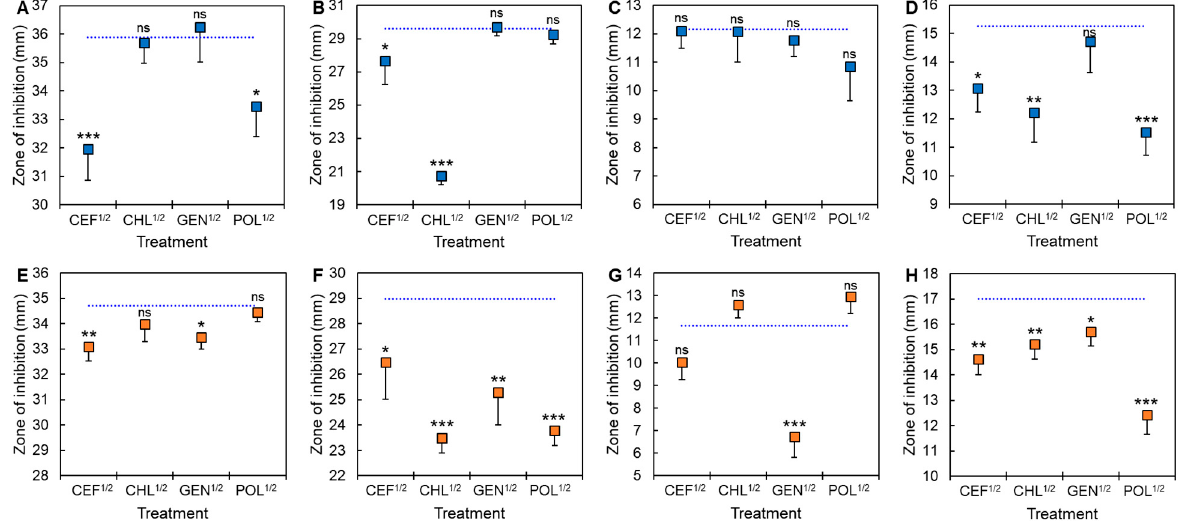
Figure 3. Cross-resistance of Salmonella Typhimurium ATCC 19585 (ST ATCC ; A – D ) and S . Typhimurium CCARM 8009 (ST CCARM : E – H ) exposed to a half minimum inhibitory concentration (MIC) of cefotaxime (CEF 1/2 ), chloramphenicol (CHL 1/2 ), gentamicin (GEN 1/2 ), and polymyxin B (POL 1/2 ) to cefotaxime ( A , E ), chloramphenicol ( B , F ), gentamicin ( C , G ), and polymyxin B ( D , H ). The dotted lines represent untreated ST ATCC and ST CCARM . ns indicates no significant difference and *, **, and *** denote significance differences at p < 0.05, p < 0.01, and p < 0.001, respectively.